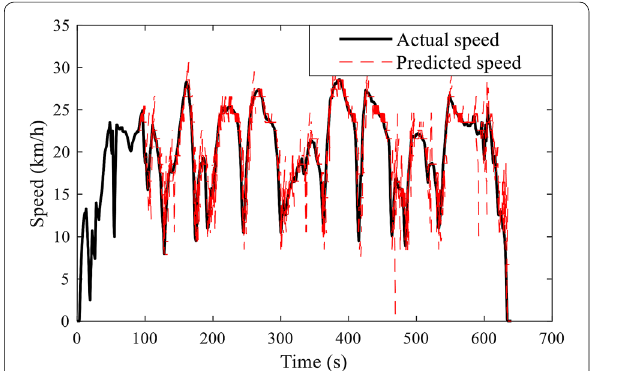
Figure 12 Markov speed prediction